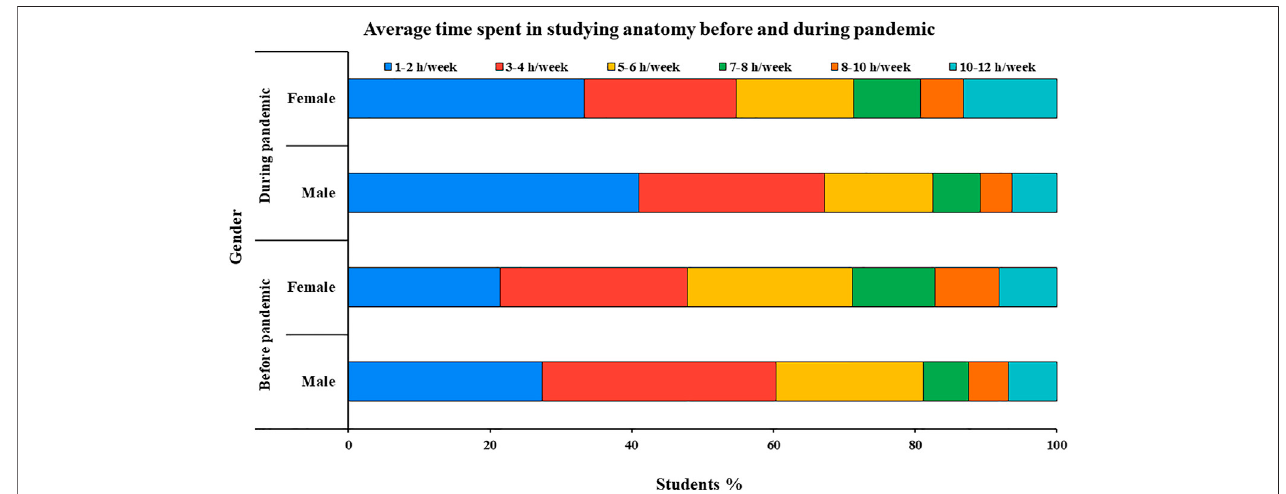
FIGURE 4 | Evaluation of average studying time of anatomy online before and during the lockdown